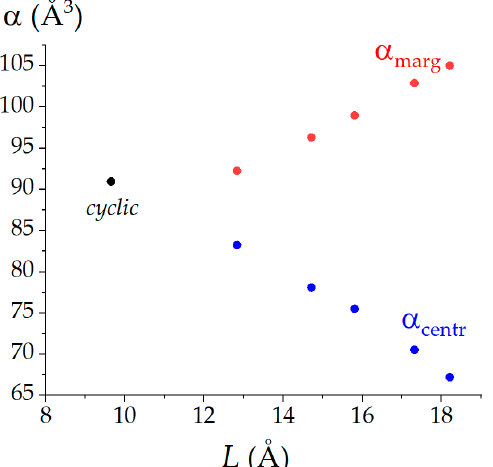
Figure 3. The contributions from central and marginal fullerene cores ( α centr and α marg , respectively) to the mean polarizabilities of the (C 60 ) 3 nanostructures as a function of the marginal cores’ remoteness. The point corresponding to the cyclic fullerene trimer is separately selected as all its fullerene units are equivalent. The data associated with the plot can be found in Table 1.